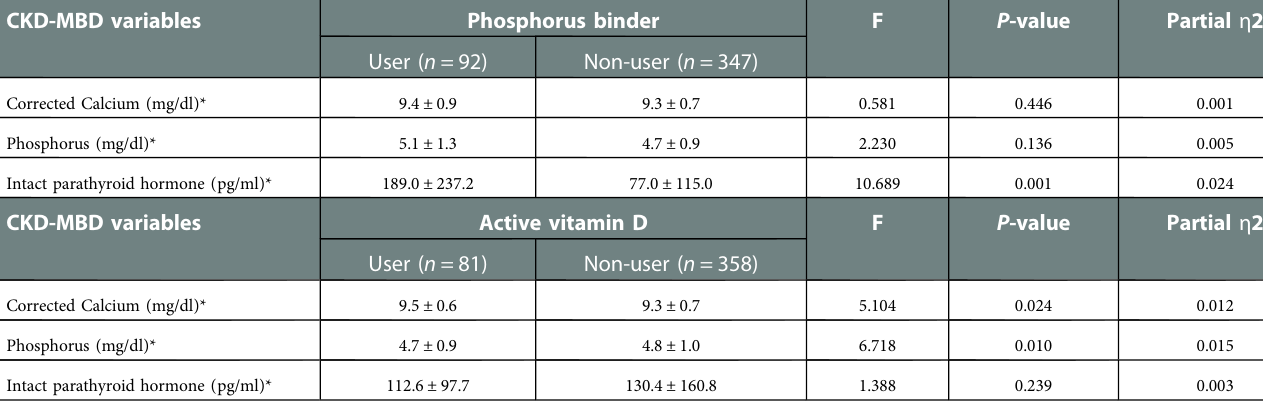
TABLE 4 MANCOVA to determine the difference between the patients with and without medications on CKD-MBD